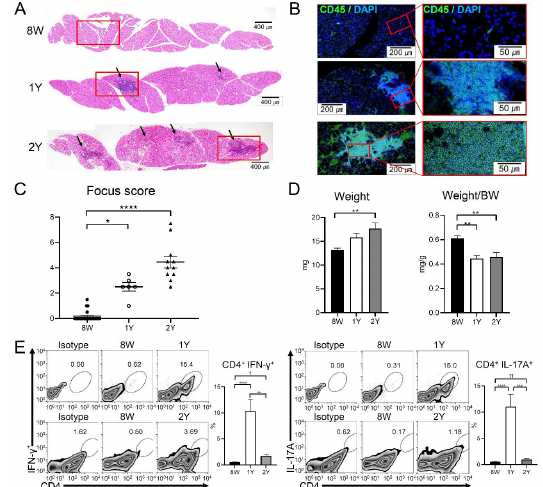
Figure 5. Representative images of the lacrimal gland (LG) sections acquired by ( A ) H&E staining (50×) and ( B ) CD45 immunofluorescence staining (100× and 400×). Arrows indicate lymphocytic infiltration foci. Red boxes of subfigure A are enlarged in subfigure B. ( C ) The inflammation focus score was higher in 1Y- and 2Y-old mice than in 8W-old mice ( p = 0.010 and p < 0.0001, respectively; Kruskal–Wallis test followed by Dunn’s post hoc test; n = 22, 6, and 11 for 8W-, 1Y-, and 2Y-old mice, respectively). ( D ) LG weight was higher in 2Y-old mice than in 8W-old mice ( p = 0.003; one-way ANOVA followed by Tukey’s post hoc test); however, the body weight (BW)-adjusted LG weight was lower in 2Y- and 1Y-old mice than in 8W-old mice ( p = 0.002 and 0.001, respectively; one-way ANOVA followed by Tukey’s post hoc test; n = 8, 6, and 6 for 8W-, 1Y-, and 2Y-old mice, respectively). ( E ) After forward-scatter and side-scatter gating in the LGs, CD4 + IFNγ+ and CD4 + IL-17A + cells were identified. The percentages of CD4 + IFNγ+ cells were higher in 1Y-old mice than in 8W- and 2Y-old mice ( p < 0.0001 and p = 0.0015, respectively; one-way ANOVA followed by Tukey’s post hoc test). The percentages of CD4 + IL-17A + cells were also higher in 1Y-old mice than in 8W- and 2Y-old mice ( p < 0.0001 and p = 0.0004; one-way ANOVA followed by Tukey’s post hoc test). Although the percentages of CD4 + IFNγ + cells and CD4 + IL-17A + cells of 8W- and 2Y-old mice were not significantly different in a post hoc test ( p = 0.785 and 0.975, respectively), there was a significant difference ( p = 0.010 and p < 0.001, respectively) when an independent t-test was performed on only 8W- and 2Y-old mice. ( n = 13, 6, and 3 for 8W-, 1Y-, and 2Y-old mice, respectively.) * p < 0.05, ** p < 0.01, and **** p < 0.0001 for the post hoc test, and † p = 0.010 and †† p < 0.001 for the independent t-test. Data are presented as means ± standard error.